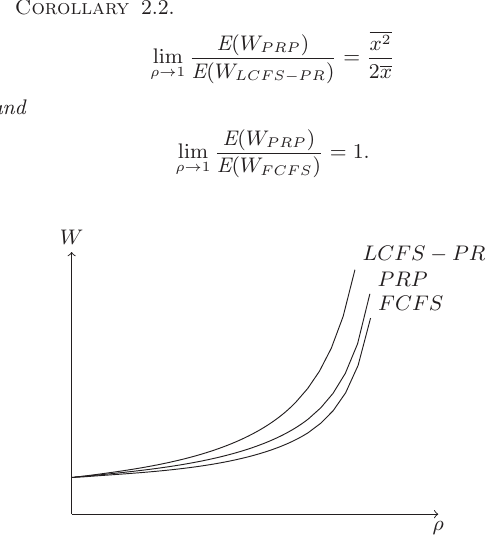
Figure 1: Mean waiting times under the three ser- vice regimes in the case ¯ x = 1 and CoV ( X ) = 0 as a function of ρ .